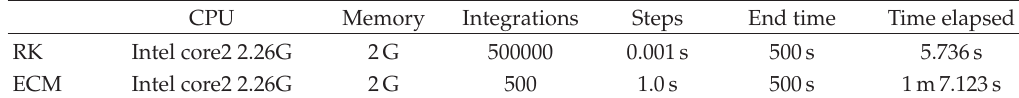
Table 1: Comparison of computing e ffi